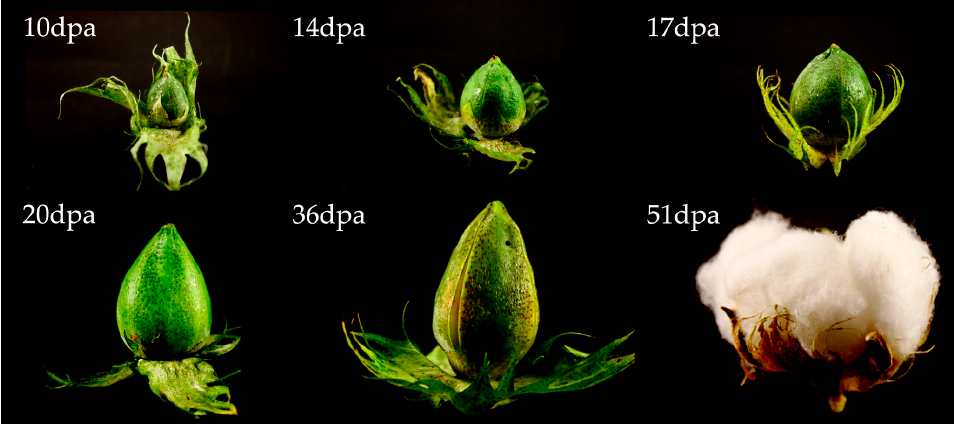
Figure 1. Representative images of different stages of development of G. hirsutum cotton (dpa = days post-anthesis) from 10 dpa until it reaches full maturity (51 dpa). During the development, the majority of the fruit volume is found to be between 1–17 dpa. During this period the volume is